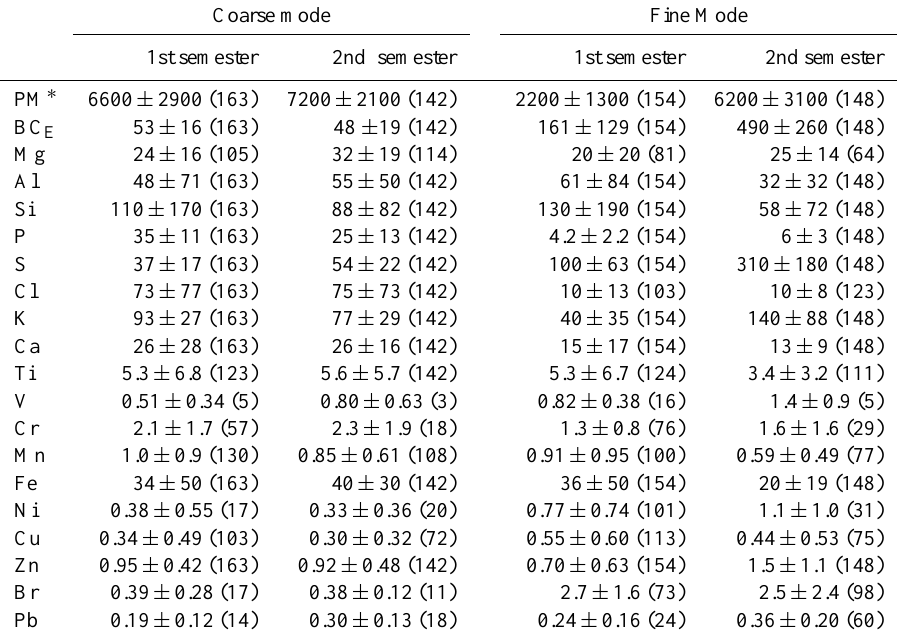
Table 1. First and second semester mean aerosol elemental composition in fine and coarse mode in Balbina, Central Amazonia.